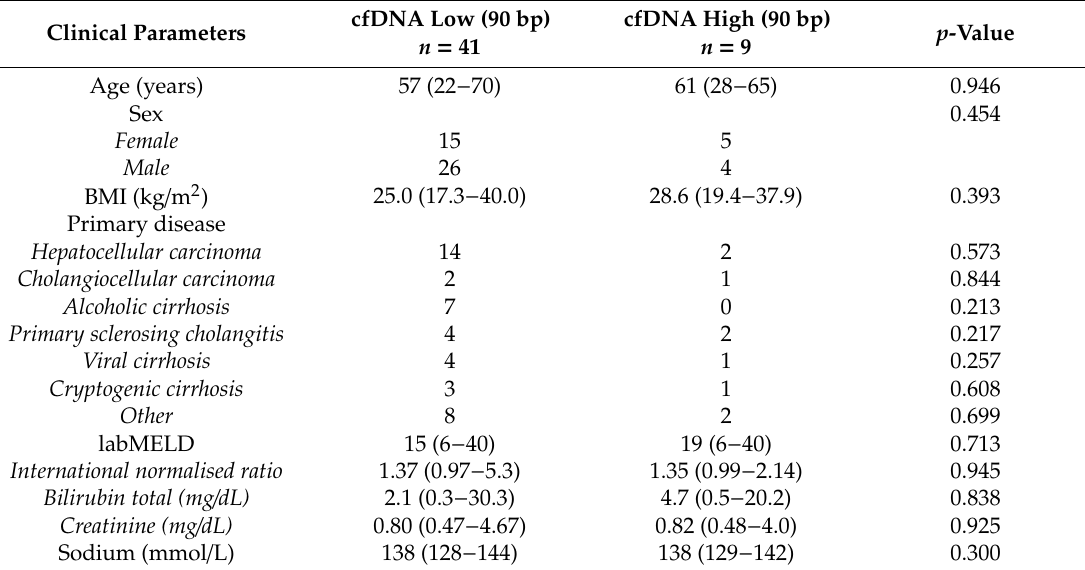
Table 1. Baseline characteristics of the study cohort before liver